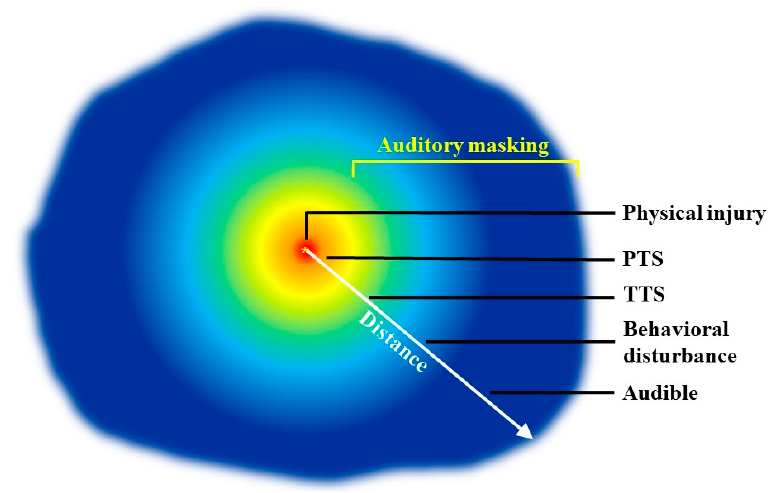
Figure 1. A simple acoustic impact model based on the distance of the source from the receiver (animal). PTS = permanent threshold shift; TTS = temporary threshold shift. See text for explana- tion.